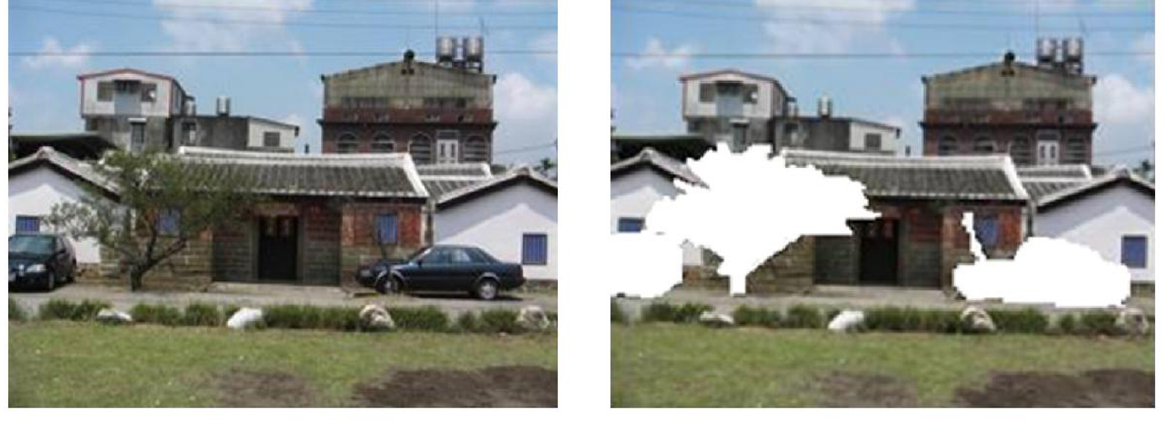
Figure 4 The Jin Guang Fu historical site 3D model with texture mapping from photographs. the recovered 3D structure with incorrect texture mapping (the roof) the recovered 3D structure with image inpainting after the foreground objects (the tree) are